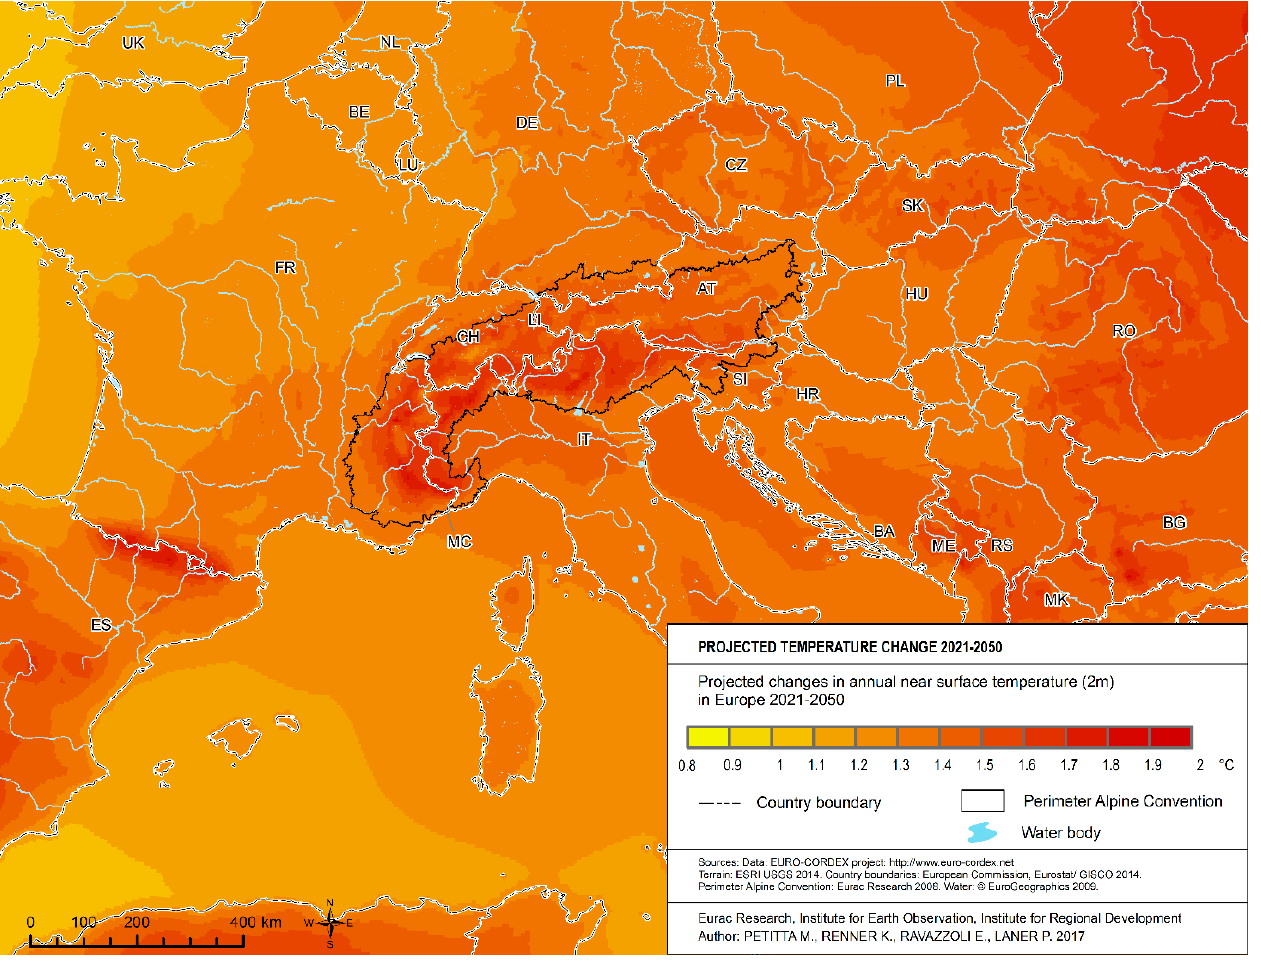
Figure 1. Projected temperature change 2021–2050. Source: Permanent Secretariat of the Alpine Convention, 2017, Eurac Research, and Permanent Secretariat of the Alpine Convention, 2017 [50]. Reprinted with the permission of the author.